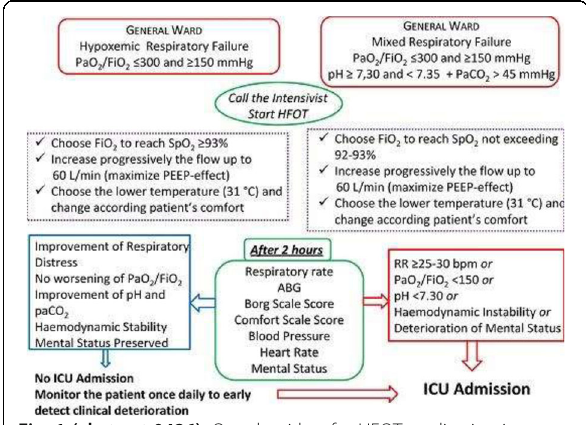
Fig. 1 (abstract 0426). Our algorithm for HFOT application in patients hospitalized in general wards